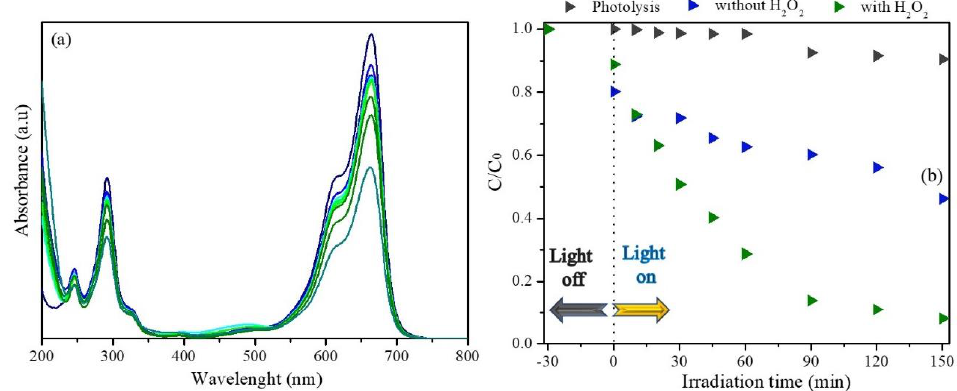
Figure 4. Photocatalytic study of Zn 0.94 Er 0.02 Cr 0.04 O sample: ( a ) spectral variation and ( b ) C / C 0 ratio